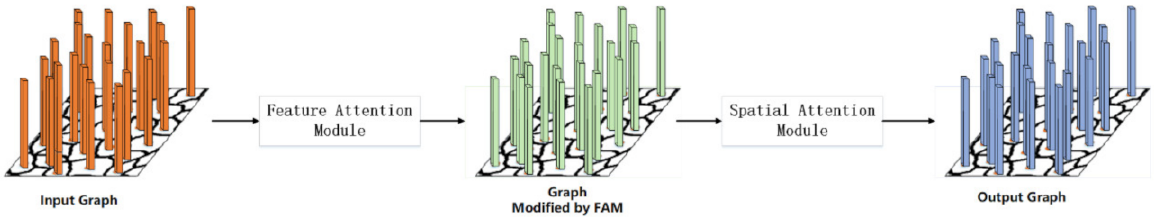
Figure 4. The overview of FSAM. The module has two submodules: a spectral attention module and a spatial attention module. The graph features are refined by FSAM.